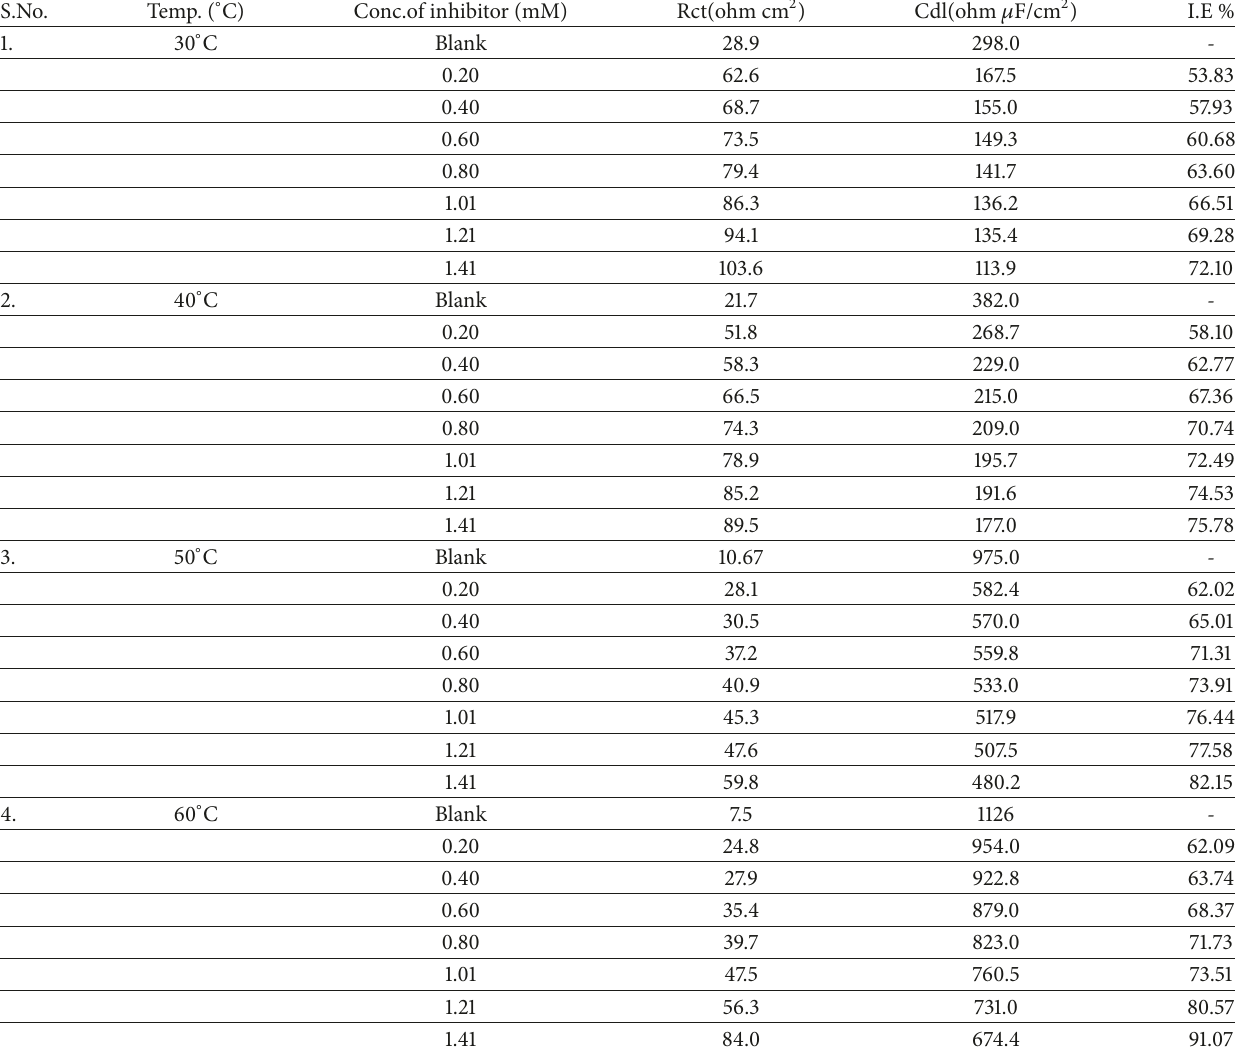
Table 3: AC impedance parameters for brass in 1M HCl with BFC from 30 ∘ C to 60 ∘ C. S.No.